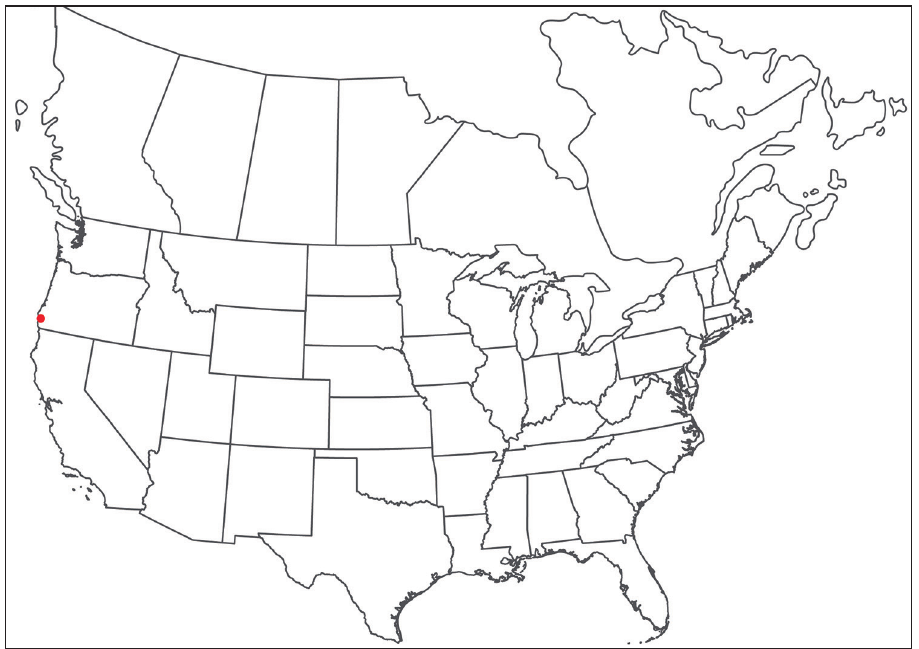
Figure 220. Torrenticola regalis sp. n.